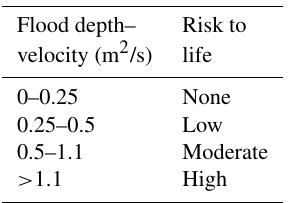
Table 3. Risk to life calculated as a function of the product between water depth and flow velocity (Priest et al., 2007).